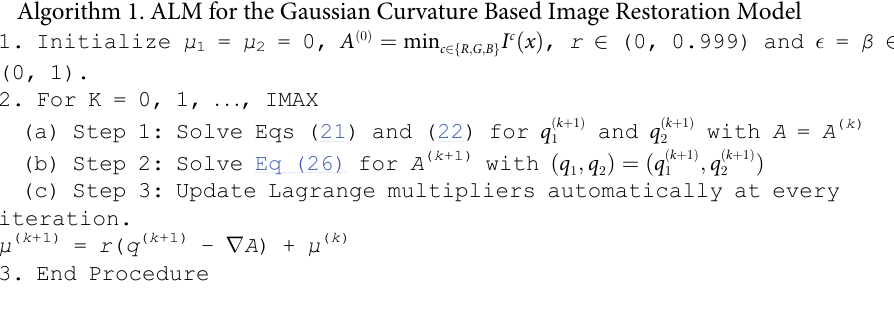
Algorithm 1. ALM for the Gaussian Curvature Based Image Restoration